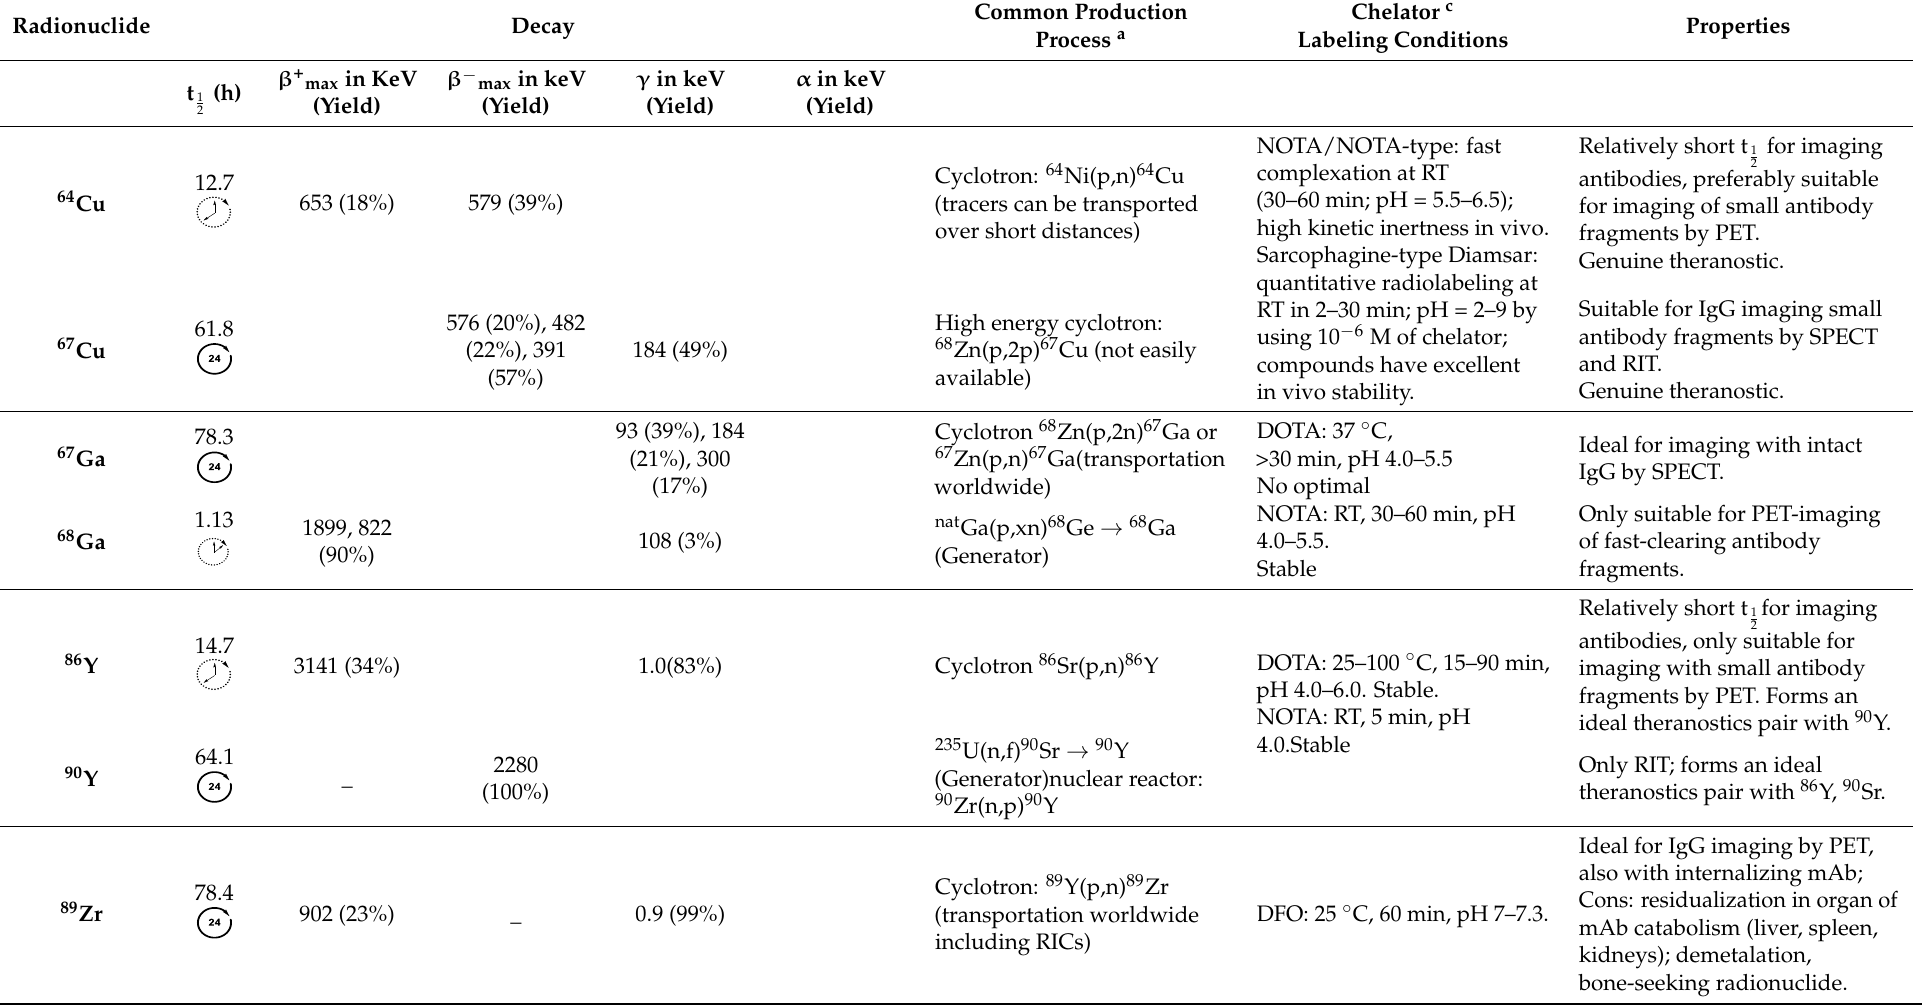
Table 2. Radionuclides used in radioimmunoconjugates for PET, SPECT, and radioimmunotherapy (RIT) .